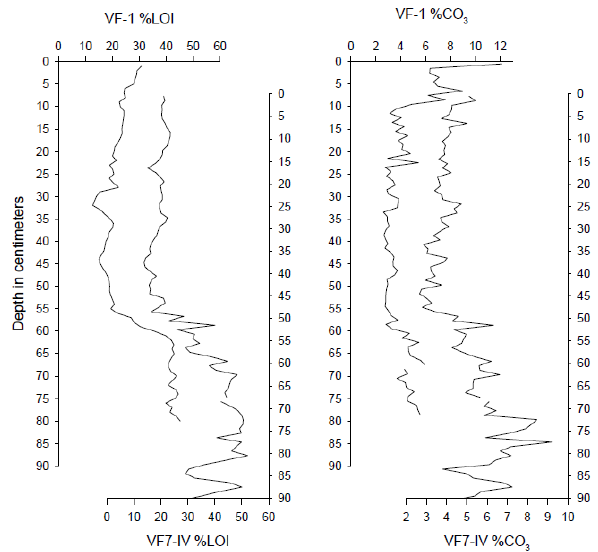
Fig. 2. Alignment of %LOI and %CO 3 profiles in cores VF-1 and VF7-IV from the western end of Verlorenvlei, showing evidence for the loss of ca. 8cm from the top of VF7-IV. Fig. 3. Age-depth model for core VF-1. Peak concentration of 137 Cs is taken to represent atmospheric bomb testing peak in 1963AD. First appearances of exotic pollen are indicated with ar- rows. The 2-sigma calendar age ranges for AMS dates on plant re- mains (black bars). The sediment-water interface was intact, so the curve meets the origin. A basal date on bulk sediment (see Table 1) lies off the time scale and is, therefore, not